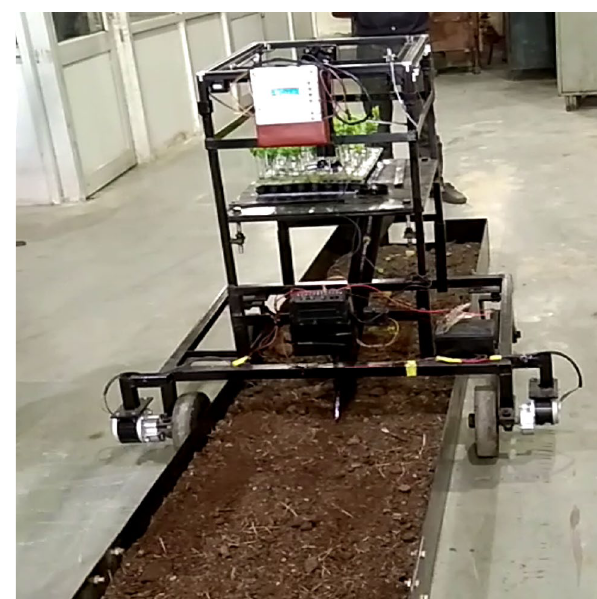
Figure 9. Test setup of robotic transplanting with plug